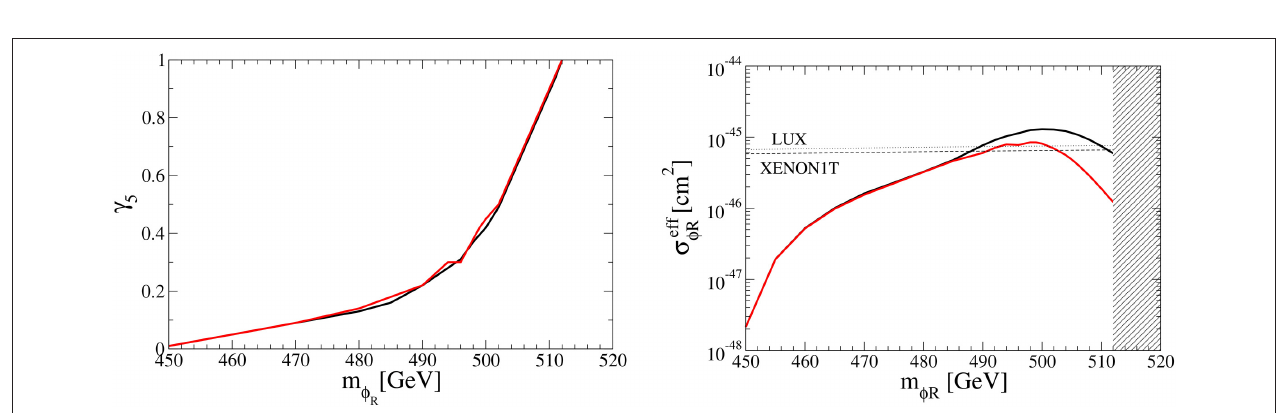
FIGURE 7 | (Left) Contour plot for the total relic density (cid:127) total h 2 The black dot and dashed lines show the upper limit of the spin independent cross section off the nucleon given by LUX [102] and XENON1T [103], respectively. The hatched region is excluded by perturbativity. In both panels, we take two values, 10 GeV (black line) and 1 GeV (red line), for the mass difference between m η 0 m χ m φ . R +